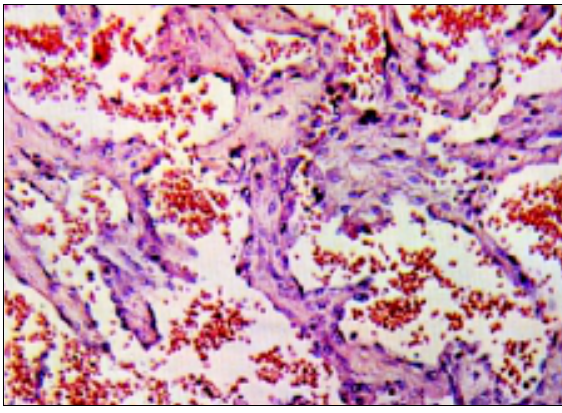
Fig. 2 - Aspecto microscópico mostrando células com intensa atipia, por vezes formando canais vasculares